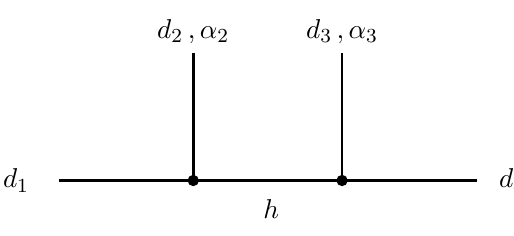
Figure 1 . Dual diagram for basic 4-point superconformal blocks on the